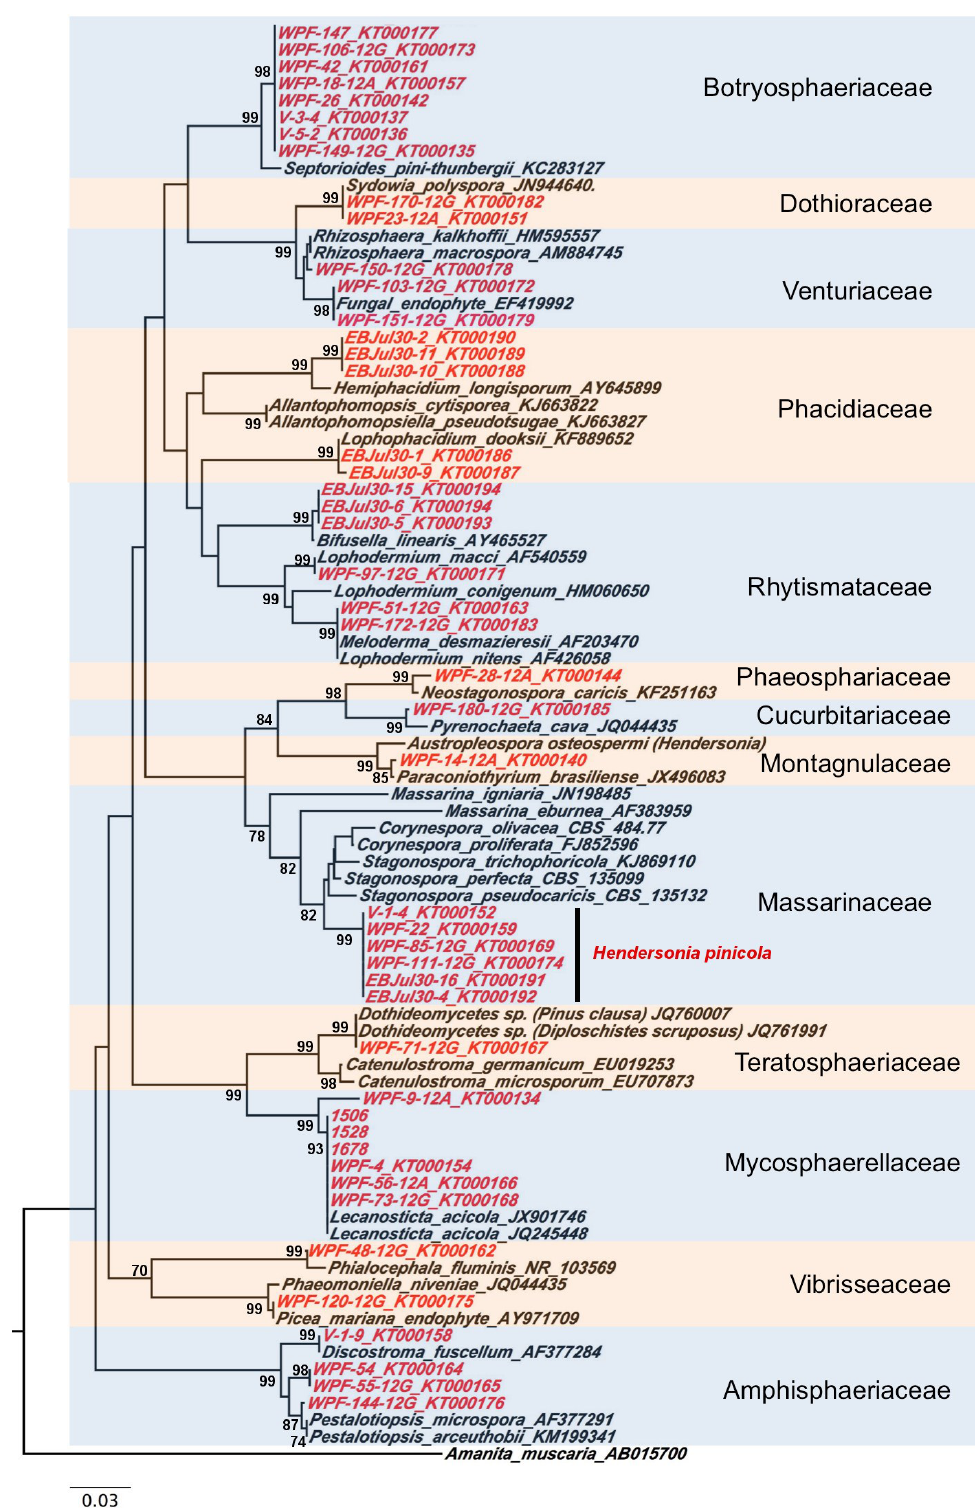
Figure 4. Neighbor-joining phylogenetic tree based on the sequence of the Internal Transcribed Spacer regions 1 and 2 of fungi isolated from symptomatic eastern white pine needles (red font) as well as closely related species imported from Genbank (black font). Isolates are followed by their respective Genbank accession numbers. Bootstrap values > 70% were included at the